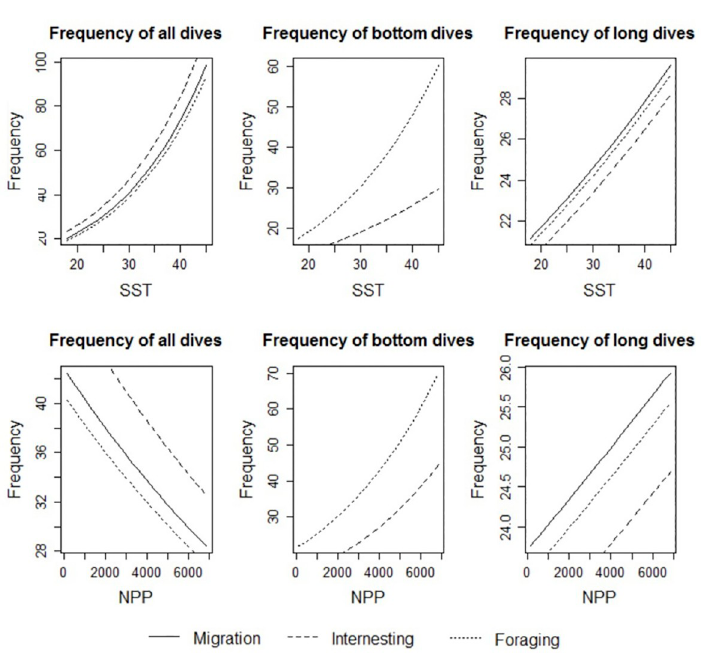
Fig 3. Prediction plots for dive metrics in relation to sea surface temperature (SST) and net primary productivity (NPP) for adult female loggerhead turtles ( Caretta caretta ) for each behavioral mode (migration, foraging and inter-nesting) in the Gulf of Mexico. Dive metrics include frequency of all dives per day, frequency of bottom dives per day, and frequency of long dives per day. For SST plots, NPP was held constant at the average value (1,763 mg C square meter -1 day -1 ). For NPP plots, SST was held constant at the average value (29˚C). Behavioral modes are indicated by differing dash patterns. Note the variable y-axis scales for each plot.